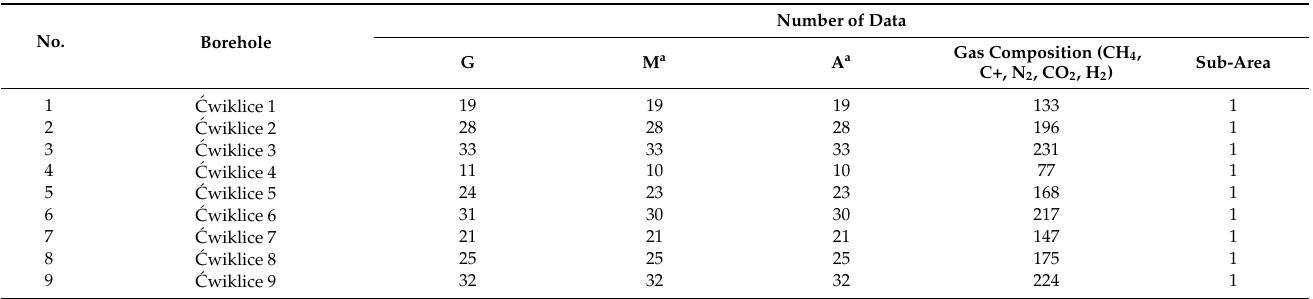
Table 1. List of boreholes drilled in the ´Cwiklice and Dankowice sub-areas with numbers of data. G—methane content, M a —moisture content, A a —ash